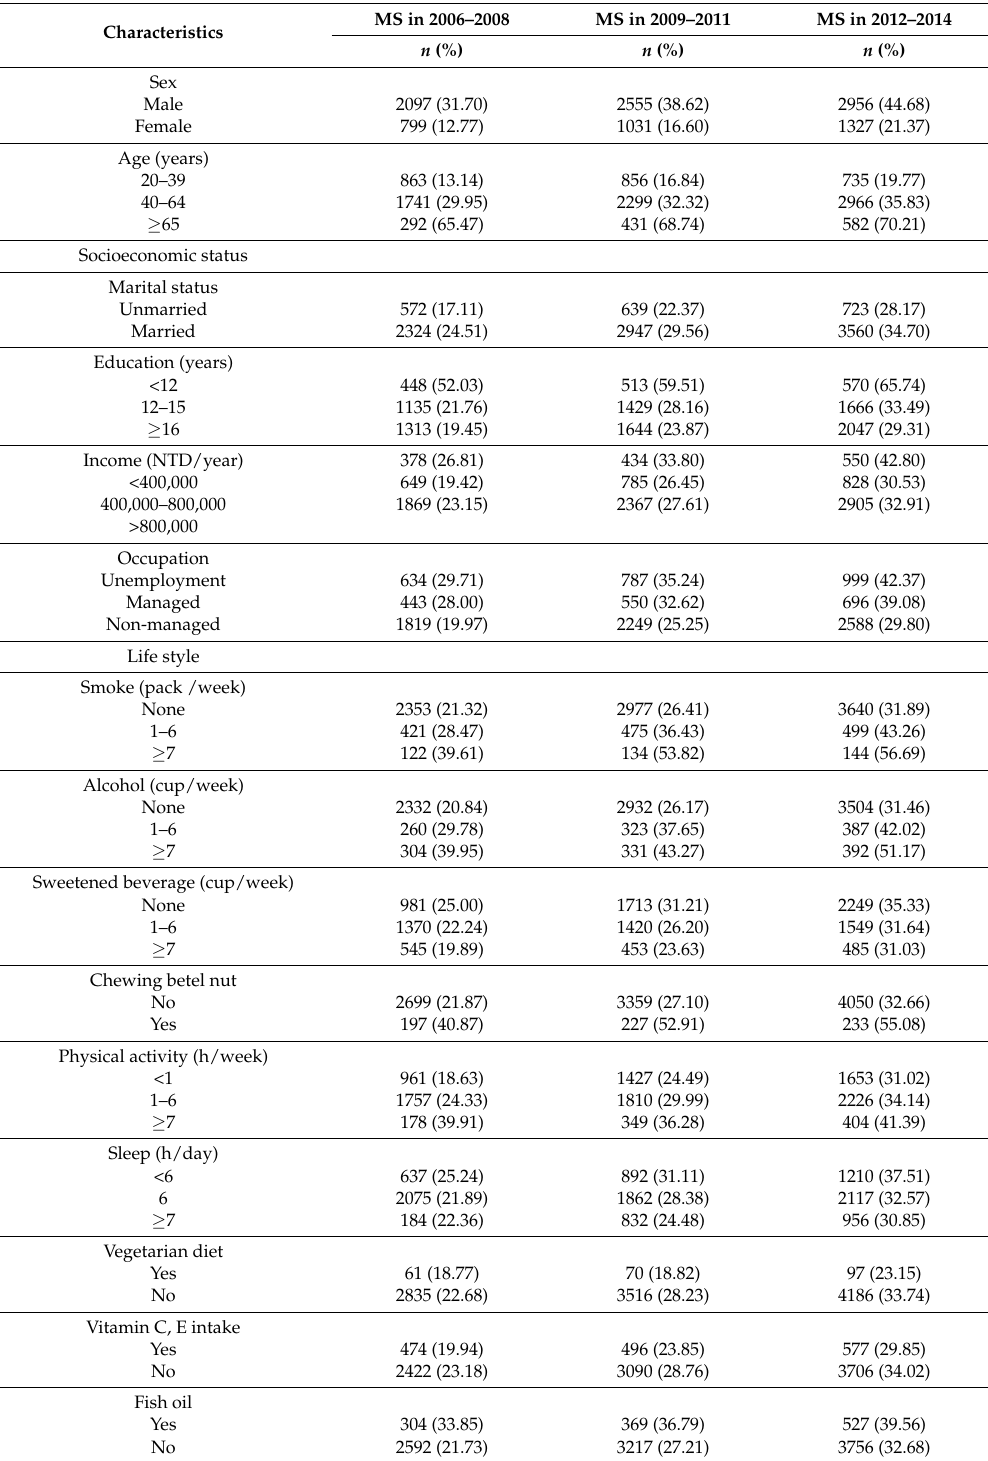
Table 1. Sociodemographic characteristics and lifestyle habits related to metabolic syndrome (MS) over the three study